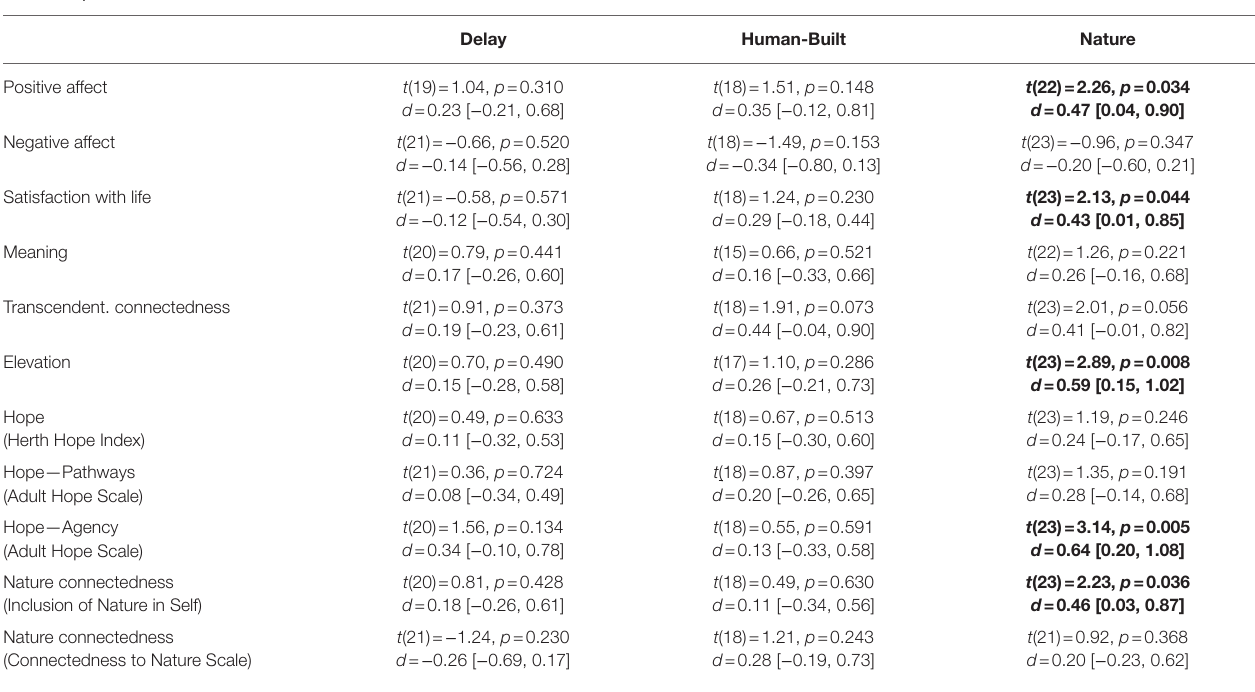
TABLE 3 | Paired t